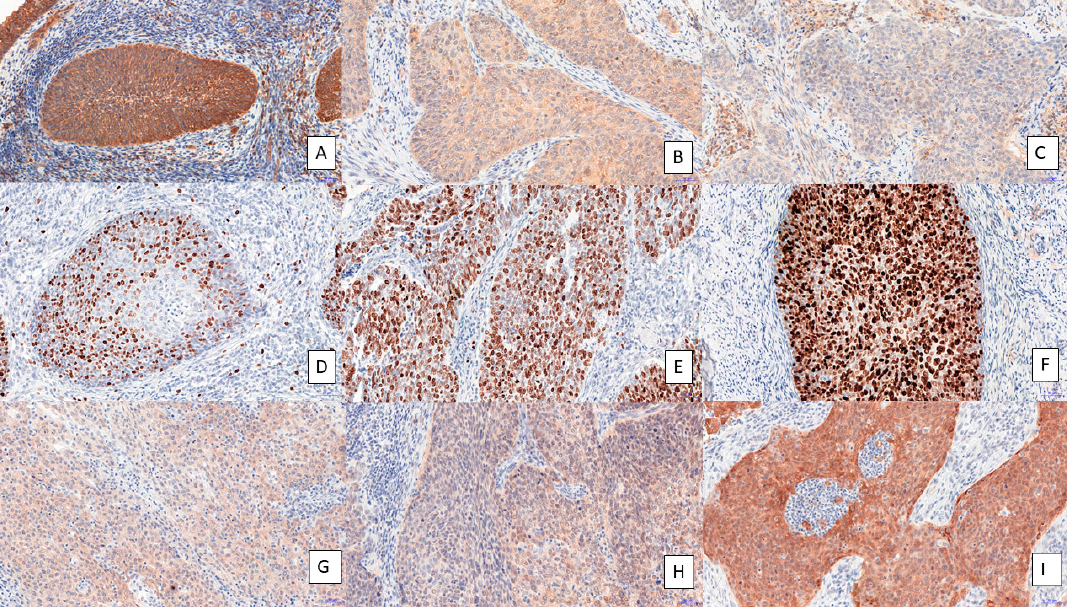
Figure 2. Immunohistochemical expression of testin in cervical cancer samples of different histological grades (( A ), G1; ( B ), G2; ( C ), G3), Ki-67 (( D ), G1; ( E ), G2; ( F ), G3) and p16 protein (( G ), G1; ( H ), G2; ( I ), G3) in cervical cancer cases. Magnification ×200.